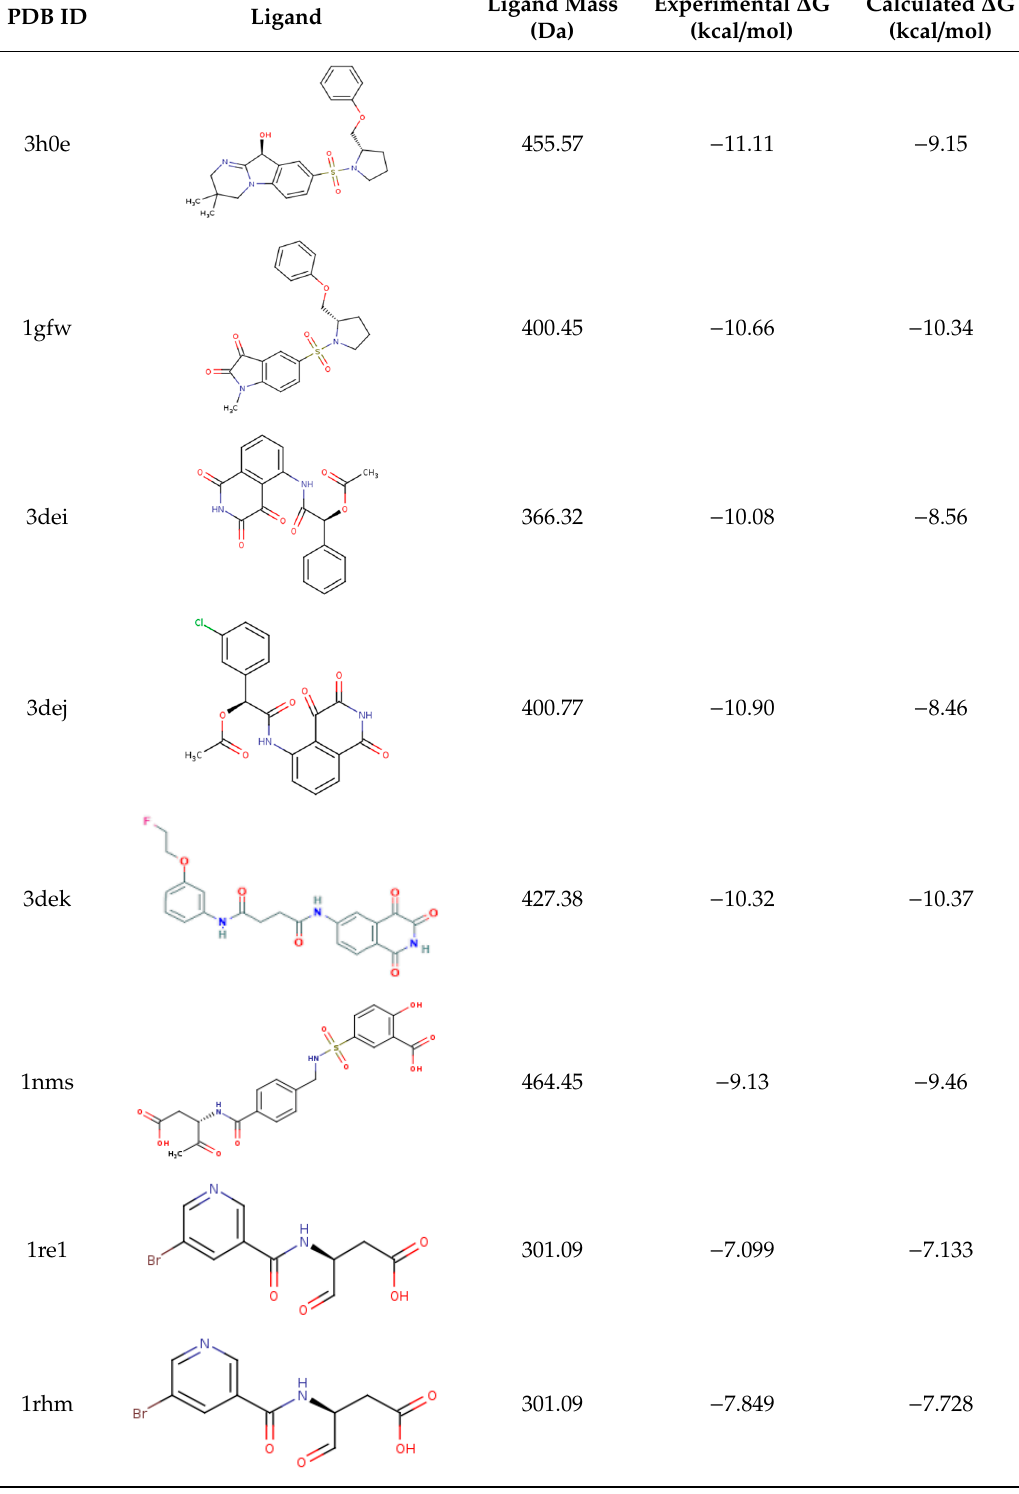
Table 1. Comparison of the binding free energy calculated by Moveable Type to that obtained from experiment for the caspase-3—small molecule inhibitor test set.